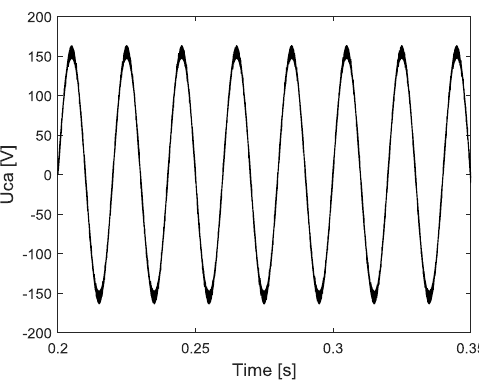
Figure 22. Waveform of capacitor voltage u ca with set 1 : r c = 2.5 Ω, K vp = 0.2, f z = 700 Hz .